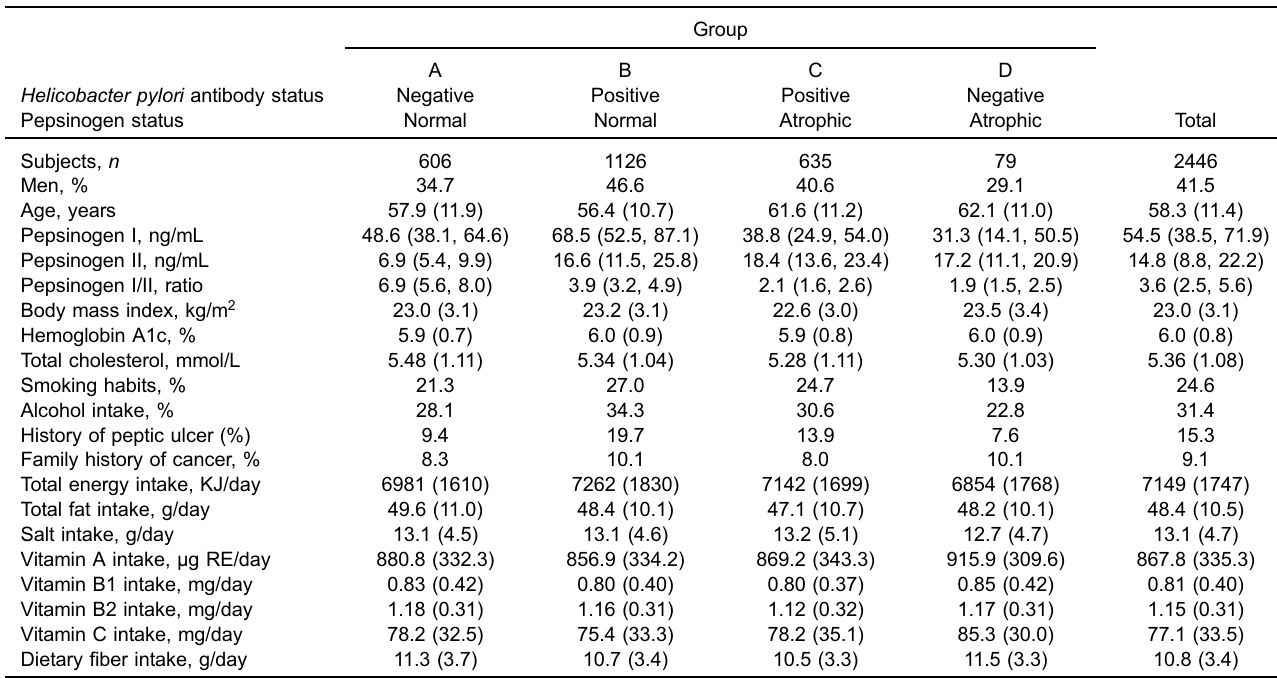
Table 1. Baseline characteristics of the subgroups classi fi ed according to the combination of Helicobacter pylori antibody and serum